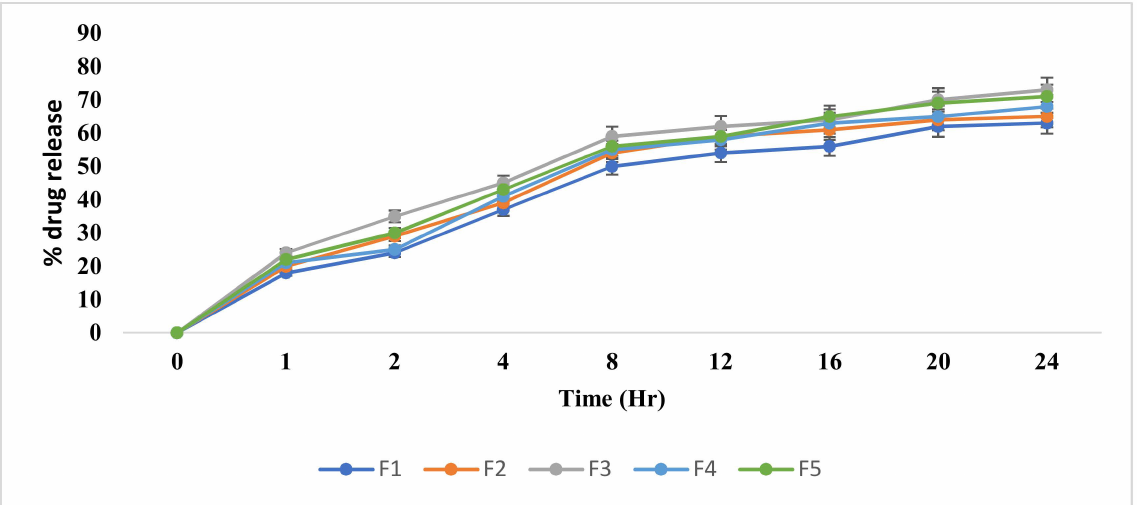
Figure 2. Percentage of EU release from nanoemulgel formulations. The data is presented as the mean ± SD and analyzed using one way ANOVA. p < 0.01 refers to F5, which is statistically significant for